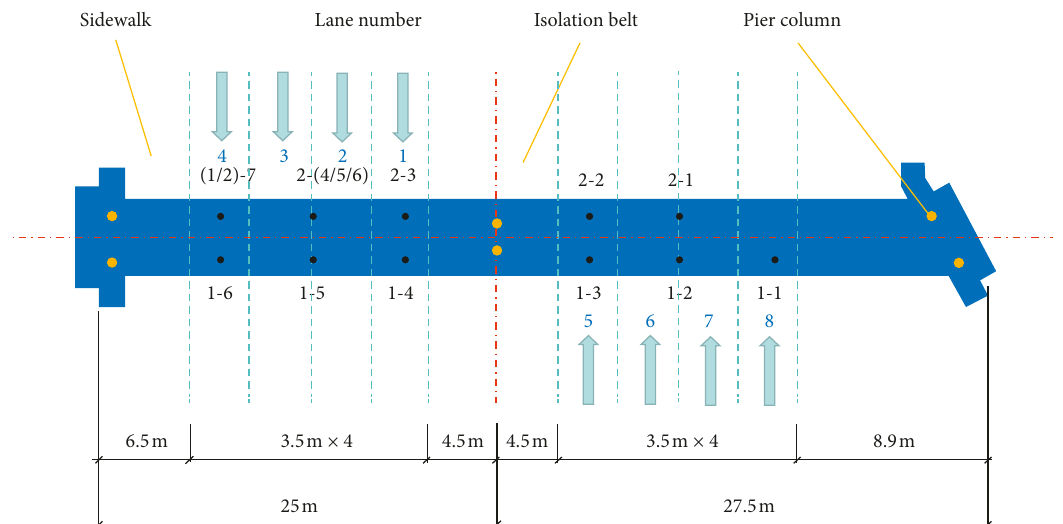
Figure 4: Layout of pedestrian bridge dynamic test